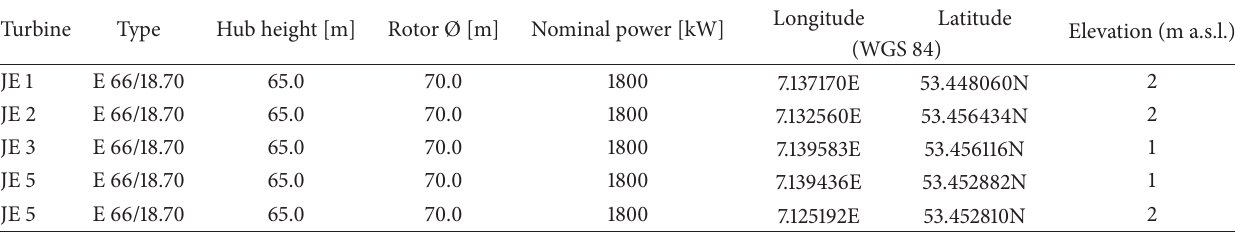
Table 2: Coordinates and data of the wind turbines at the site Jennelt